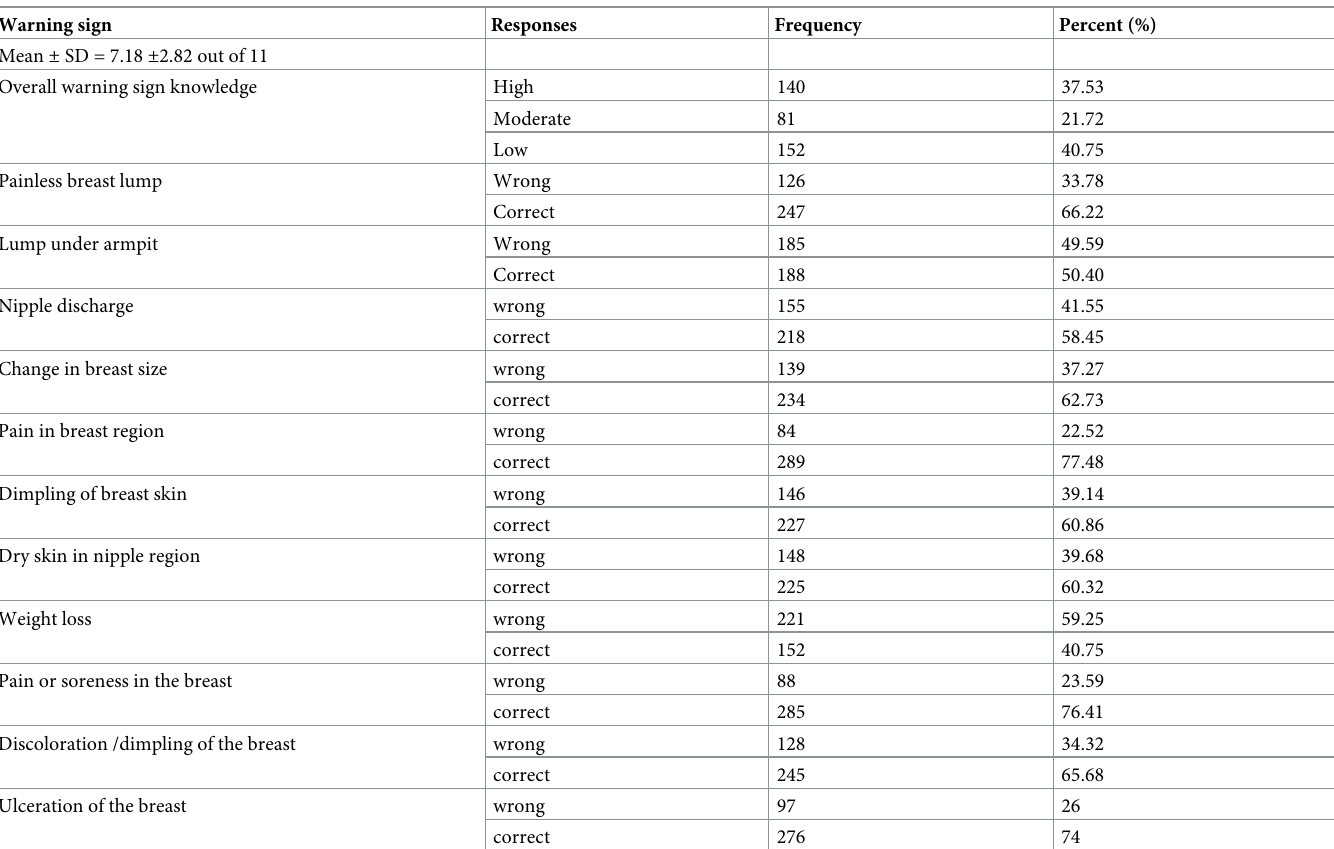
Table 3. Respondents knowledge about warning signs of breast cancer, Gurage zone.